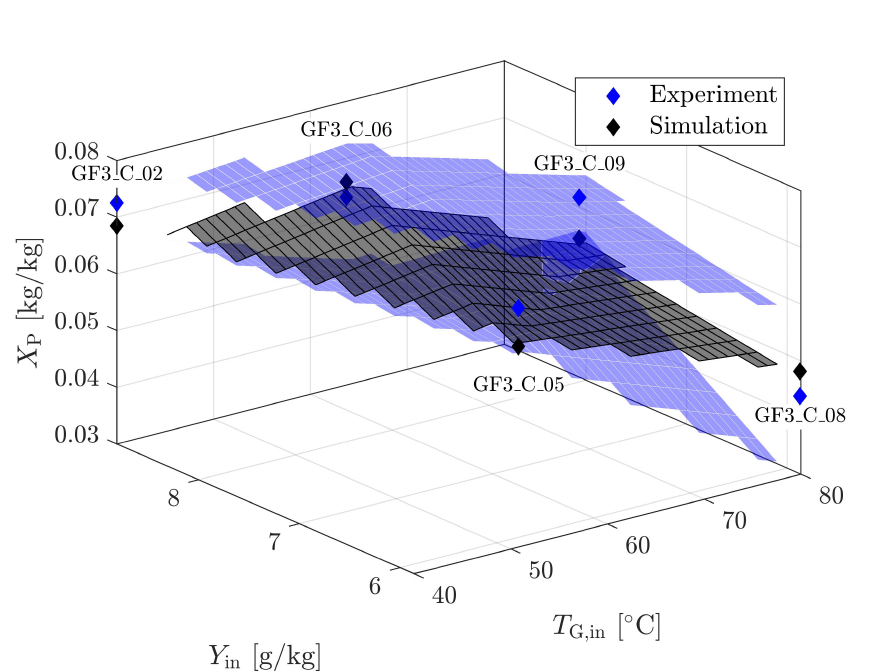
Figure 9. Comparison of measurements and model predictions of particle moisture content ( X P ), plotted against drying temperature ( T G,in ) and inlet moisture content of air ( Y in ), in the GF3 lab-scale dryer for Cellets. The dark gray area designates model predictions; light blue areas indicate the upper and lower boundary of measurement errors. Detailed information about the process conditions of the represented data points is given in Table 2.